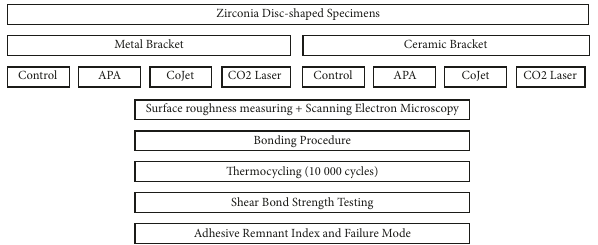
Figure 1: Schematic diagram of experimental procedures (APA: airborne-particle